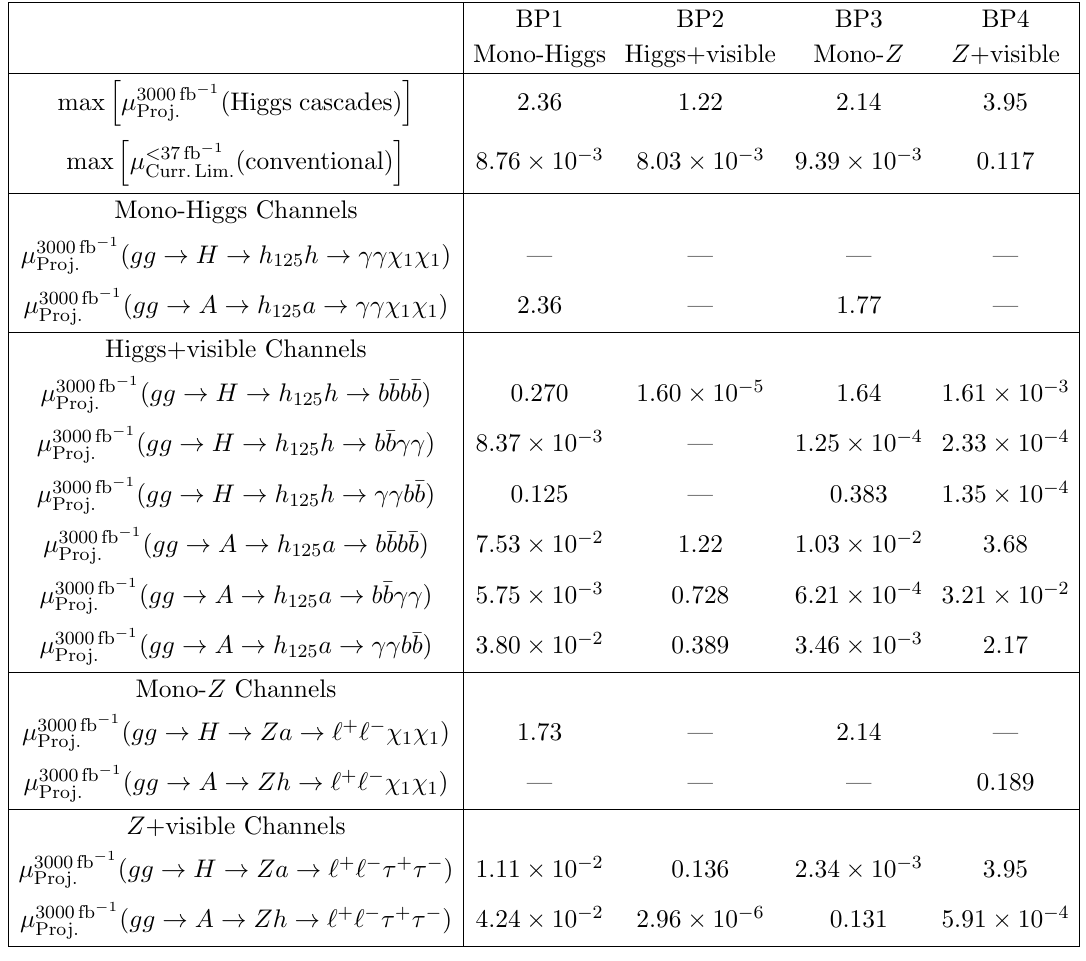
Table 4 . LHC signal strengths for the benchmark points BP1 (cid:0) BP4 de(cid:12)ned in table 3. In the (cid:12)rst two rows we record the signal strength projected at the LHC for L = 3000 fb (cid:0) 1 of data in the h dominant Higgs cascade channel, max (cid:22) 3000fb (cid:0) 1 Proj